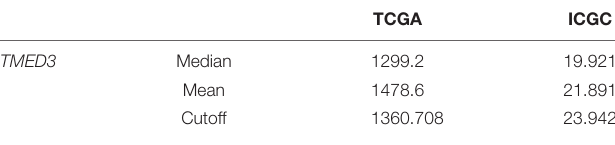
TABLE 2 | TMED3 expression levels in the TCGA and ICGC